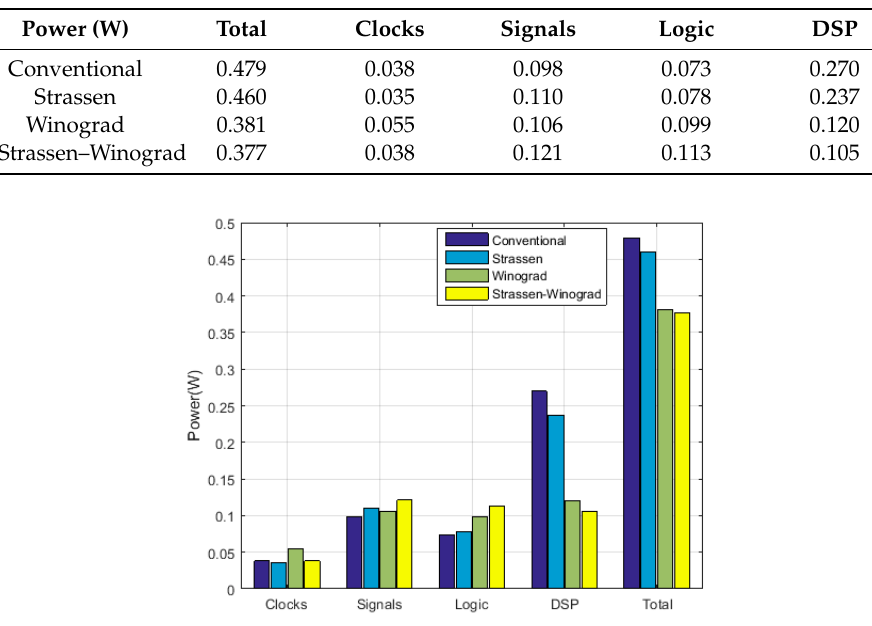
Table 3. Power consumption for di ff erent designs.